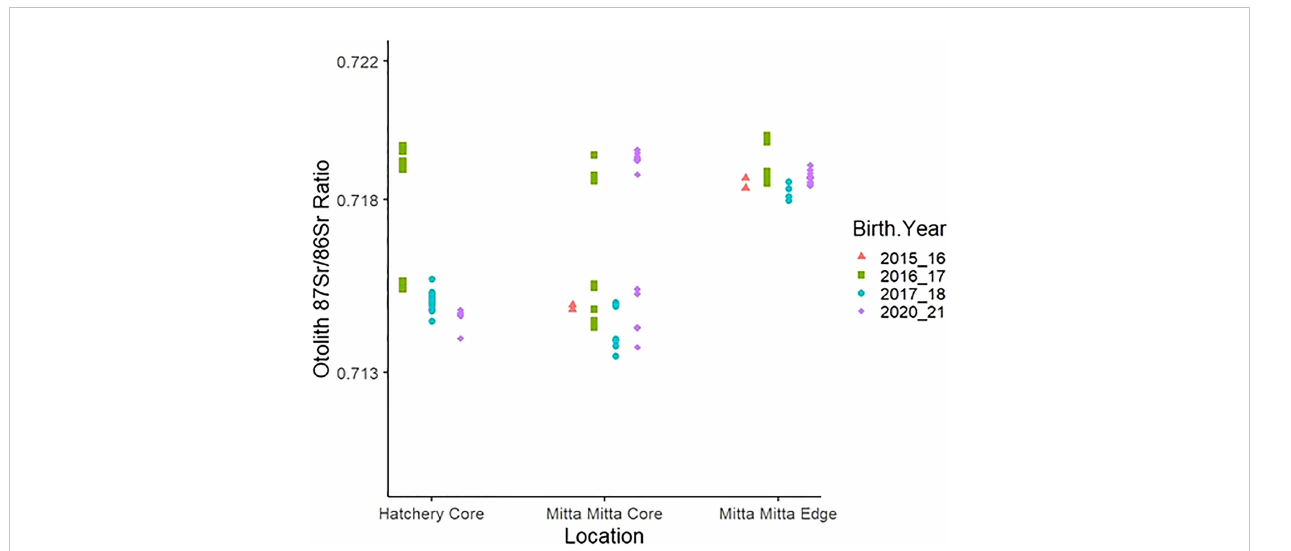
FIGURE 5 Otolith 87Sr/86Sr ratios measured from the otolith core (natal signature) of each individual hatchery fi sh and Mitta Mitta River-caught fi sh, and the otolith edge of each the Mitta Mitta River-caught fi sh (river